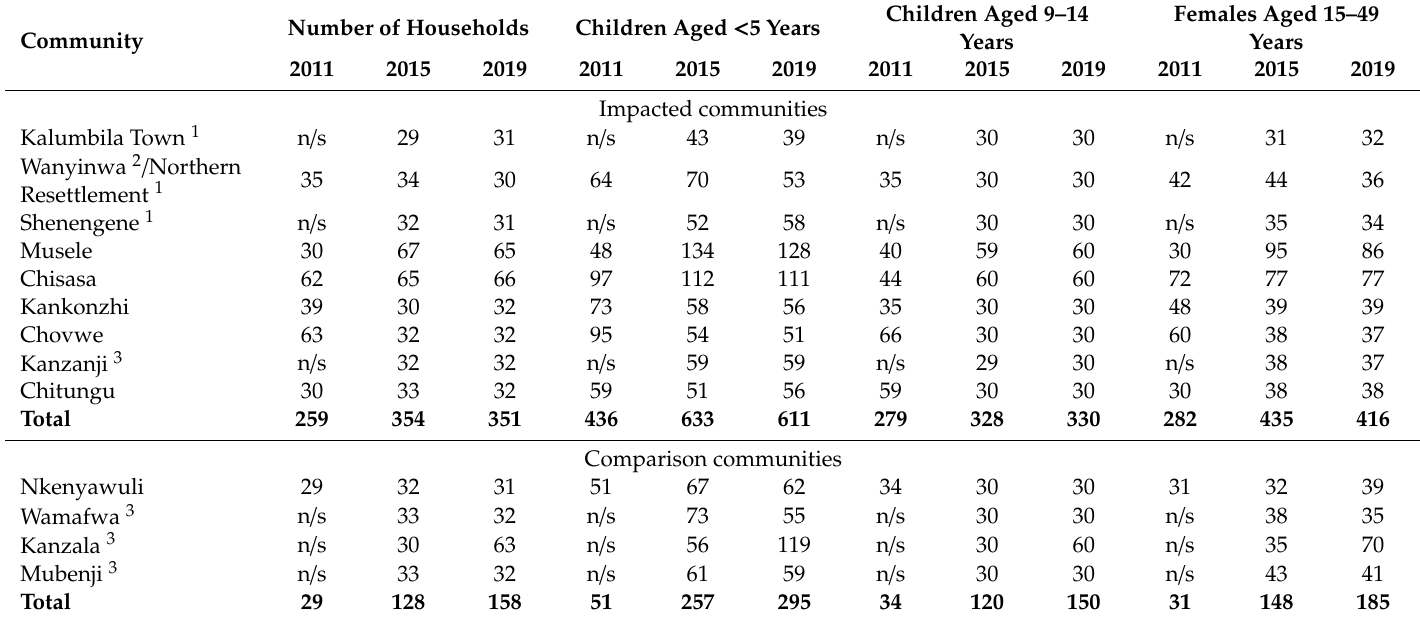
Table 1. Study population, Trident project, Zambia (2011, 2015 and